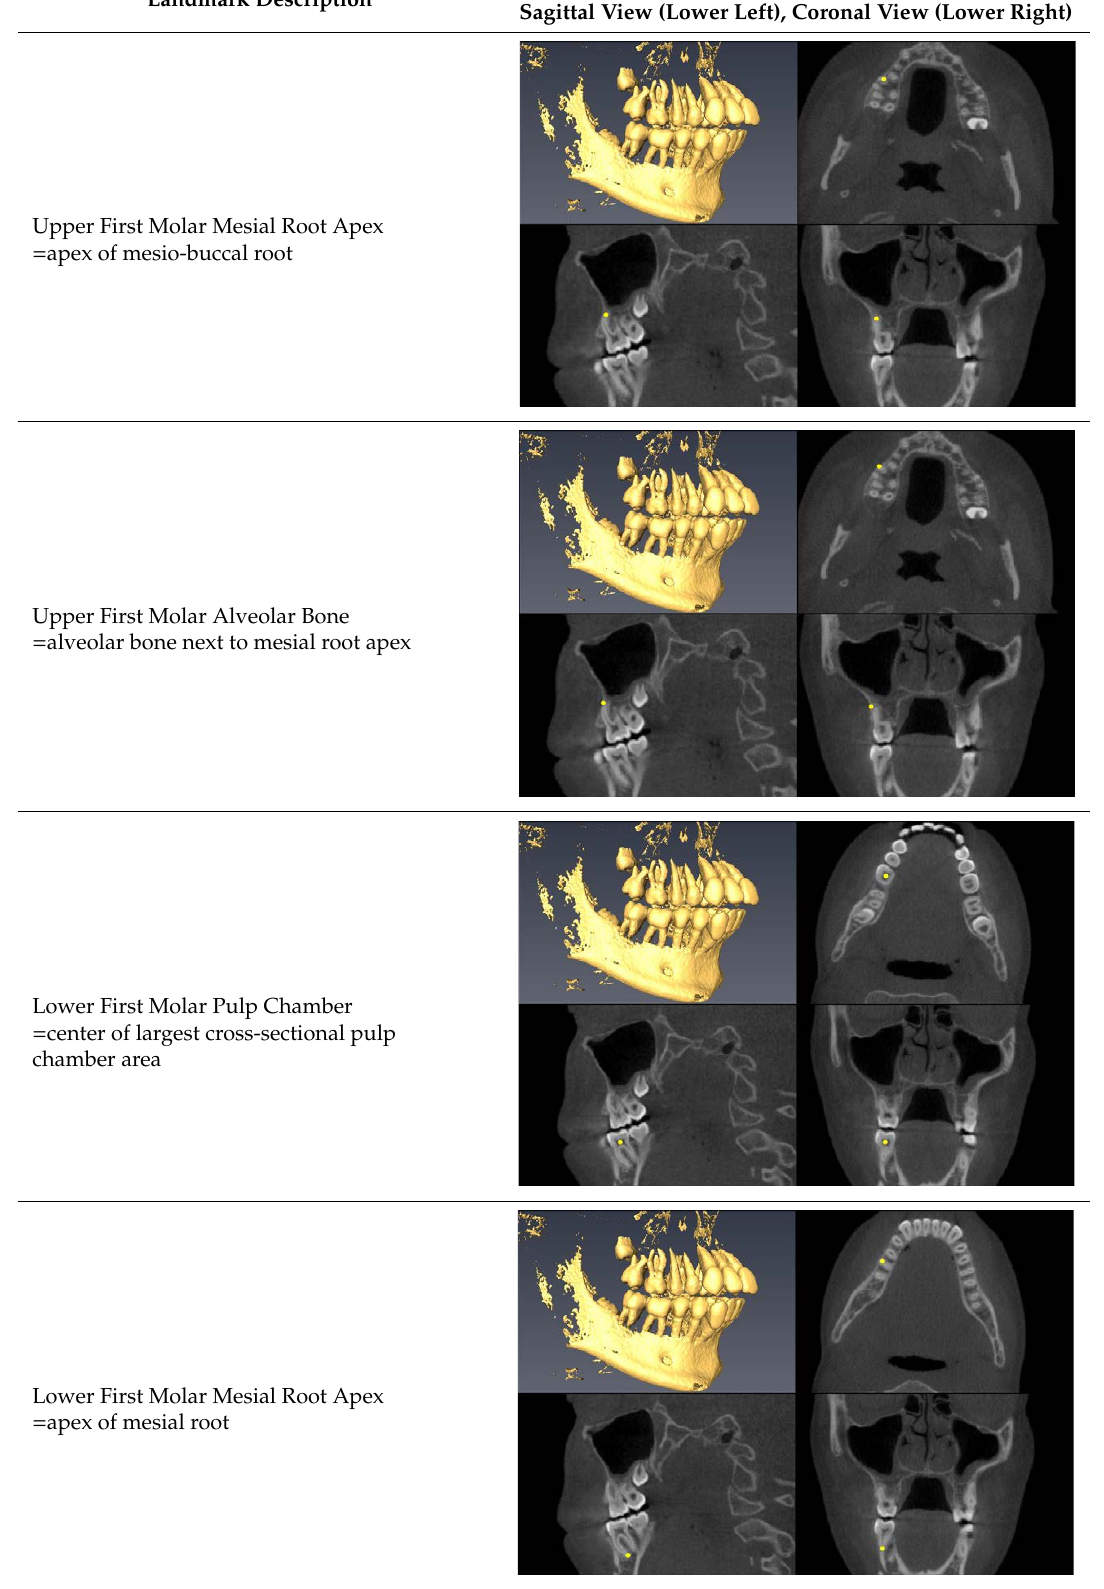
3D View (Upper Left), Axial View (Upper Right), Landmark Description Sagittal View (Lower Left), Coronal View (Lower